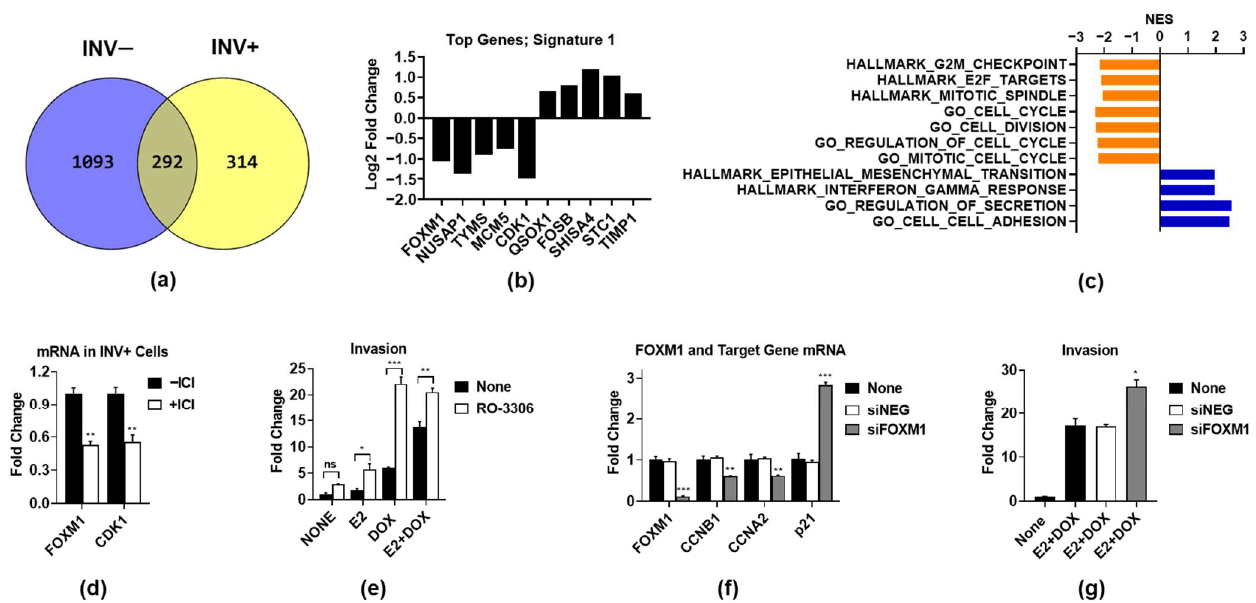
Figure 2. ER regulates a unique gene signature in invasive cells. RNA was isolated from INV+ and INV− cells as described in Figure 1, and RNA-seq was performed. ( a ) Genes regulated by ICI in INV− and INV+ cells were identified using a cutoff of FDR < 0.001 and log2 fold change (FC) of 0.5. Overlap of these gene lists in INV+ and INV− cells identified a 314-gene signature (Signature 1) specific to INV+ cells. ( b ) Log2 fold change expression is shown for the top up- and downregulated genes on the basis of FDR by ICI in INV+ cells only. ( c ) GSEA analysis of Signature 1 genes showing top significantly ( p < 0.05) enriched Hallmark and GO_biological pathways and normalized enrichment scores from MsigDB v. 7.2. ( d ) FOXM1 and CDK1 mRNA was assessed by QPCR in E2 + DOX-treated INV+ cells treated with or without ICI. ( e ) MCF-7-CA-IKKβ cells were treated with E2 +/− DOX for 72 h, followed by the CDK1 inhibitor (CDKi) RO-3306 (5 μM) for a further 16 h, and invasion was assessed. ( f , g ) MCF-7-CA-IKKβ cells were transfected with an siRNA to FOXM1, or a scrambled negative control siRNA (siNEG), and then treated with E2 + DOX for 72 h. ( f ) QPCR for FOXM1 and FOXM1 target genes was performed, and ( g ) invasion was assessed. * p < 0.05; ** p < 0.01; *** p < 0.001; ns: not significant.